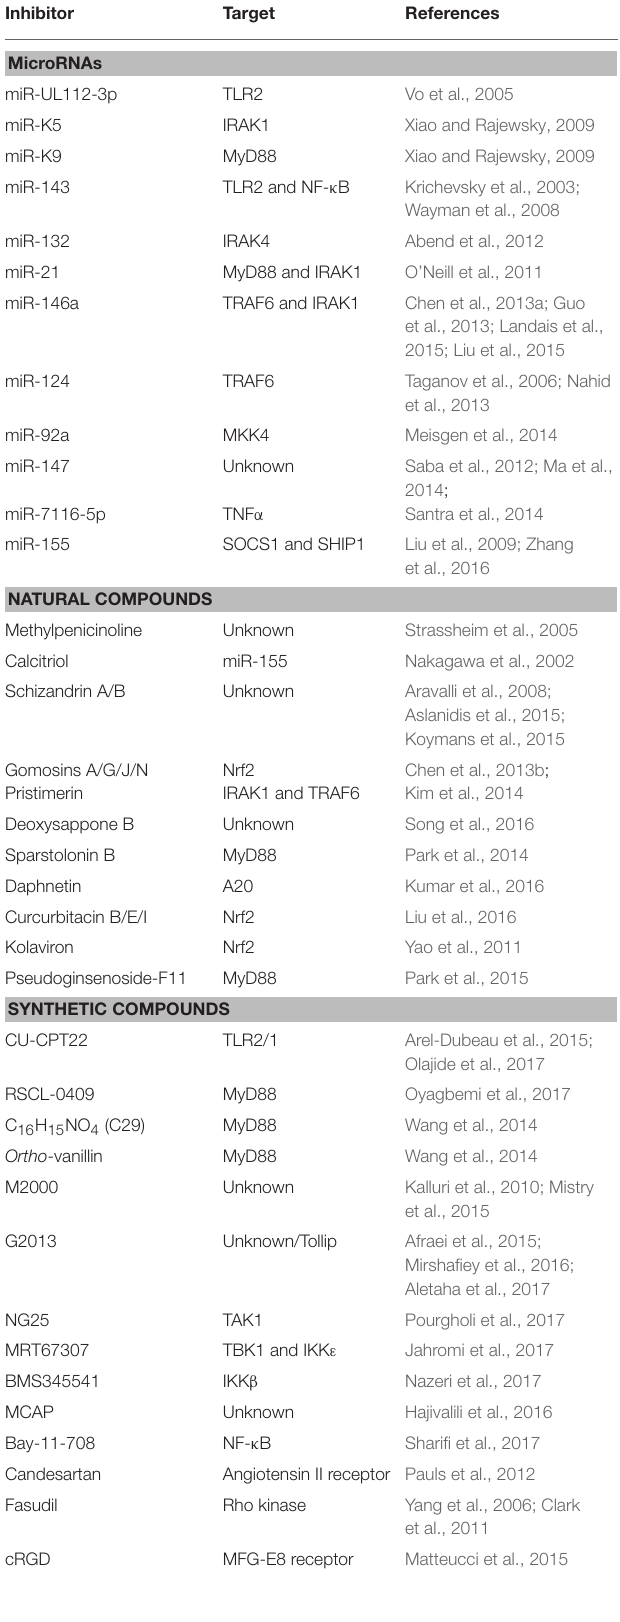
TABLE 1 | Modulators of the TLR2/1 signaling pathway.